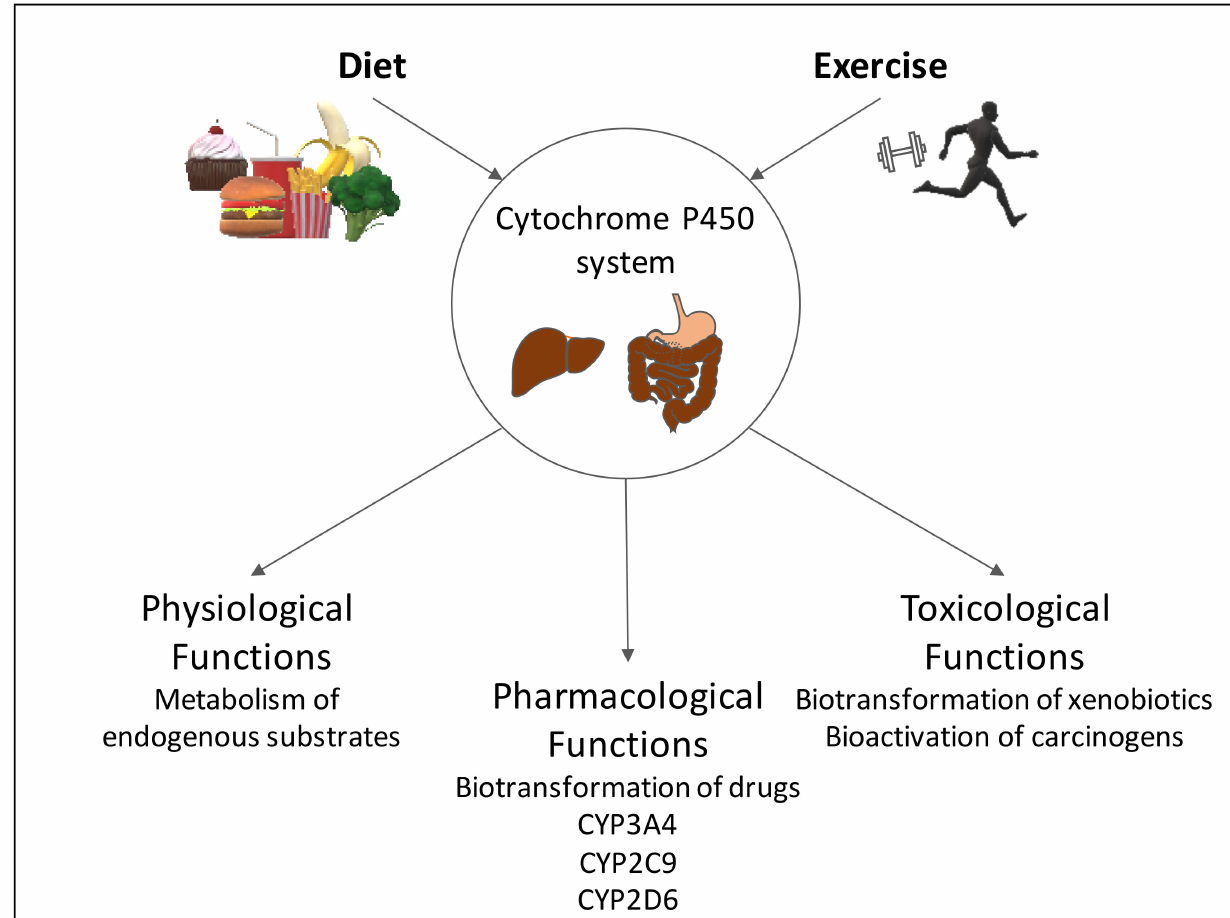
Figure 1. Schematic overview of the influence of diet and exercise on the human CYP450 system. 3.